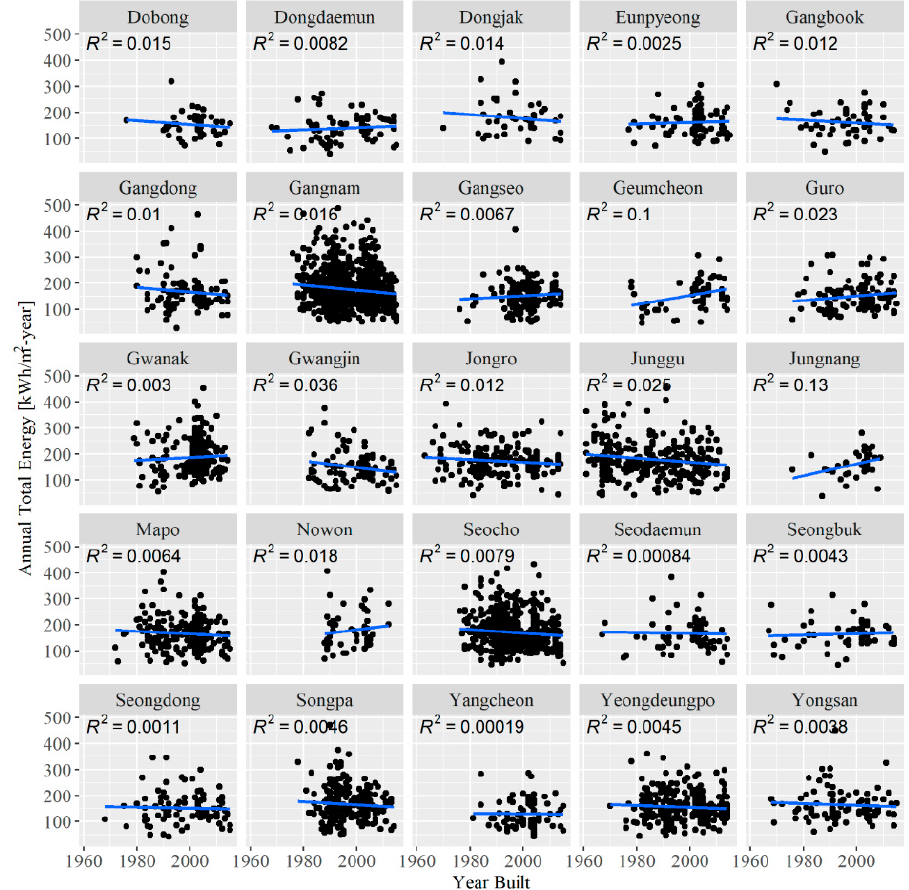
Figure 3. Scatter plots of year built versus annual total energy consumption by district in Seoul, Korea, in 2015. (The ggplot2 package on R was used).